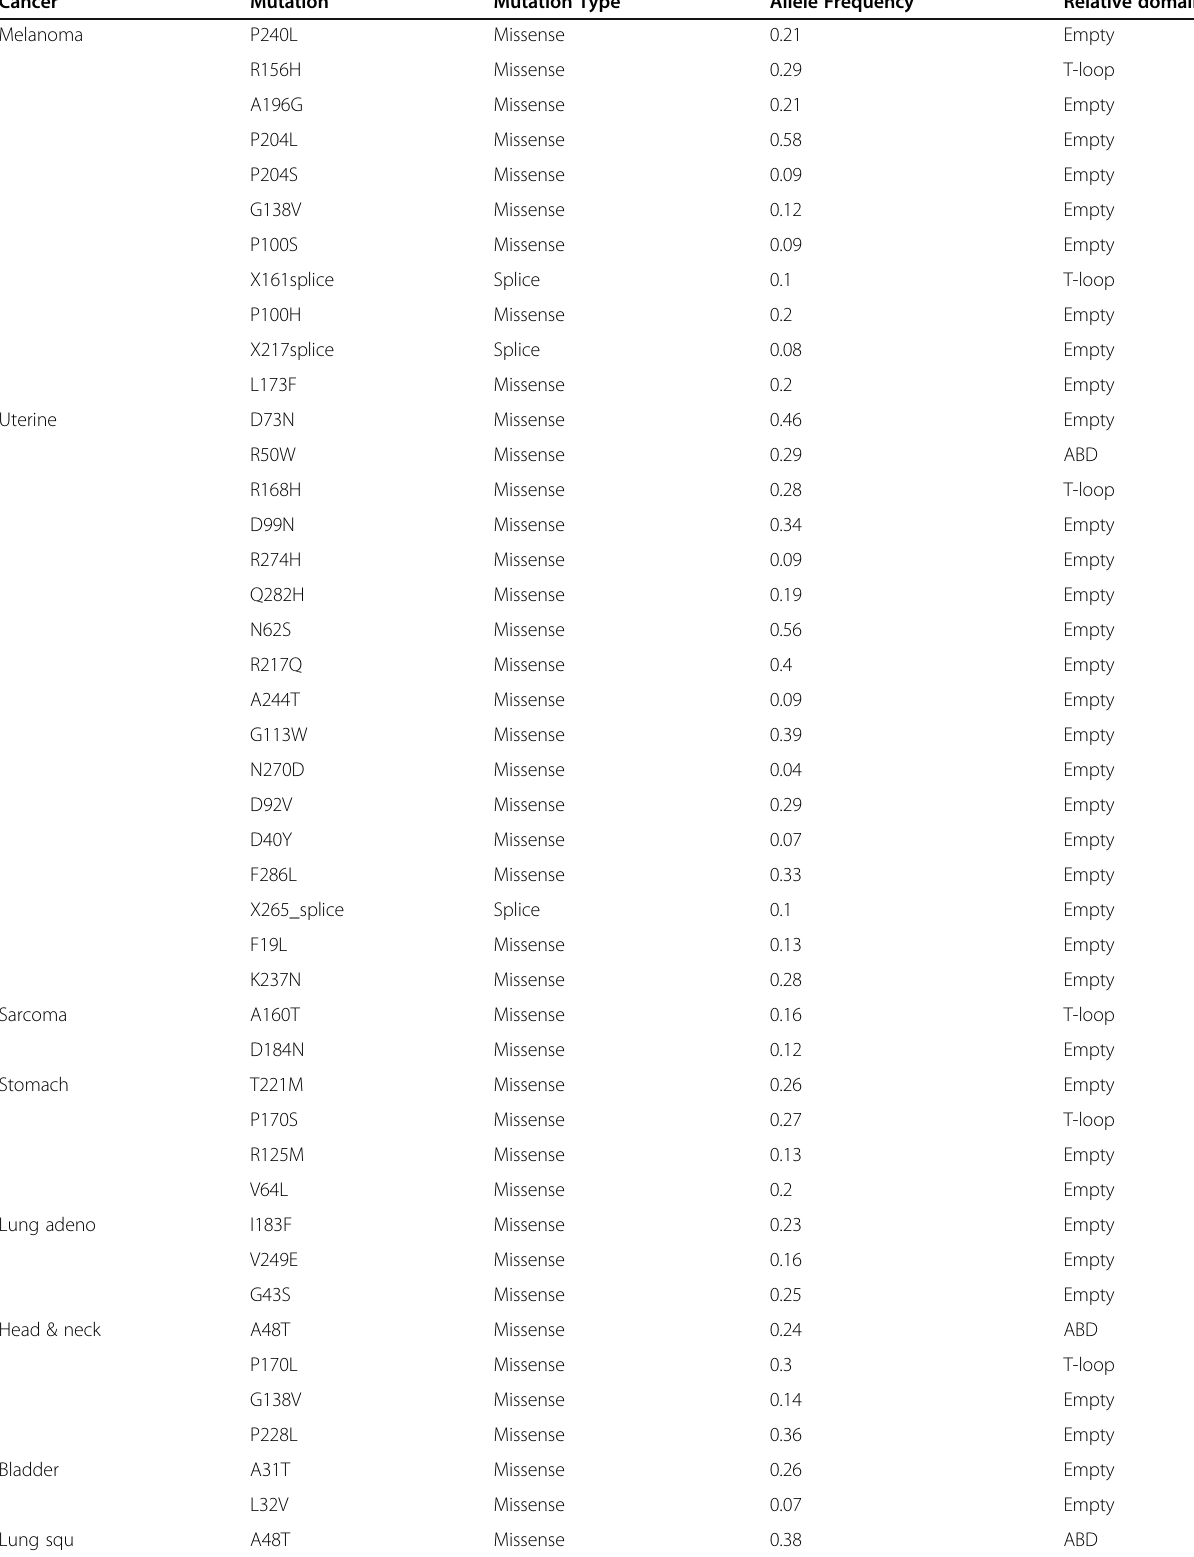
Table 1 Summary of mutation sites in corresponding domain of CDK5 and their allele frequencies in clinical cancer samples